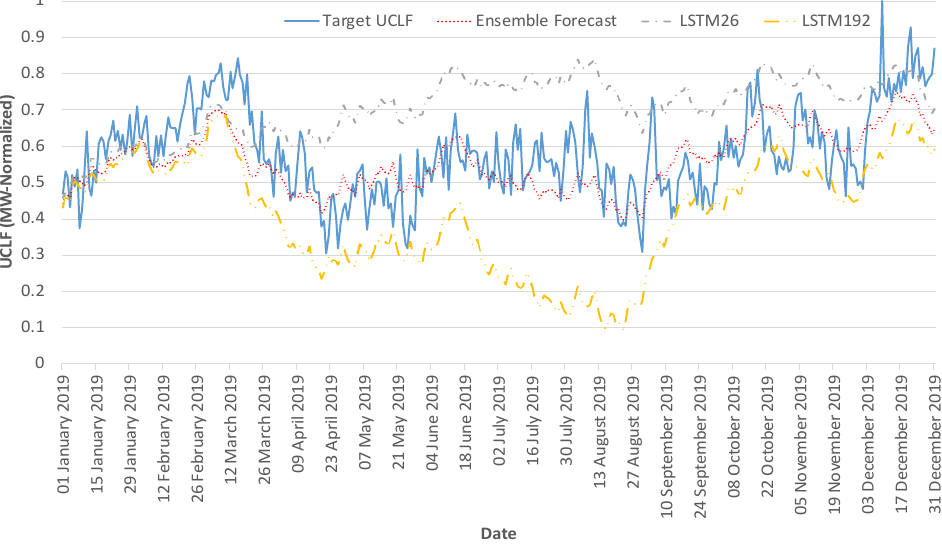
Figure 11. A plot of the ensemble lowest error model and the two aggregated models’ year-ahead UCLF forecast against the target UCLF. Table 9. Summary of lowest obtained errors per used technique.